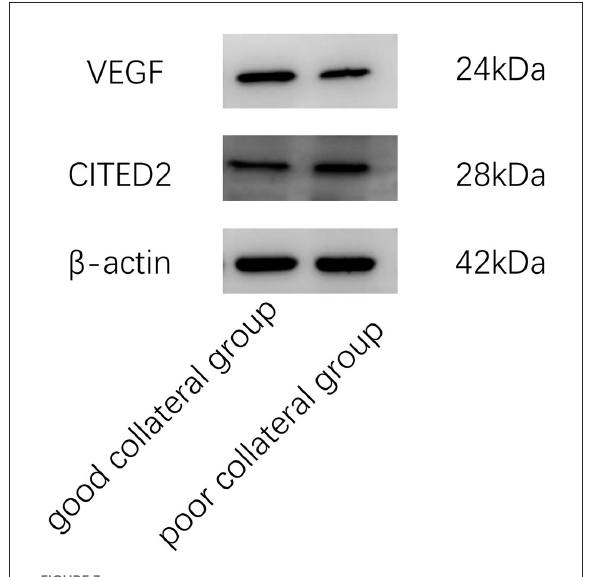
FIGURE3 Protein expression of CITED2 and